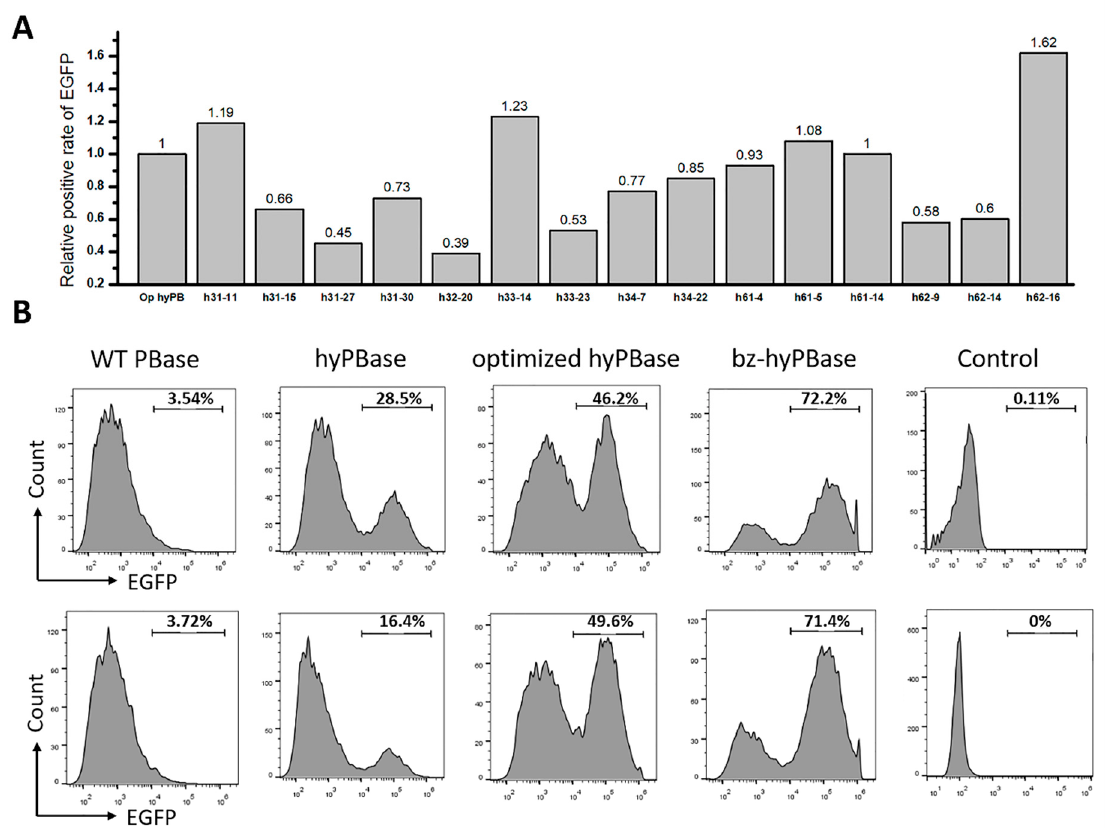
Figure 4. Hyperactive piggyBac transposase mutants in mammalian Cells. ( A ) Relative activities of 15 hyperactive mutants in Chinese hamster ovarian carcinoma (CHO) cells. The transposon plasmid pSAD-EGFP containing EGFP in transposon and the transposase plasmid pLoxP-optimized hyPBase or pLoxP -mutant containing transposase were coelectrotransformed into CHO cells. After 7 days of culture, the cells that expressed green fluorescent protein were counted by flow cytometry. ( B ) Relative activities of WT PBase, hyPBase, optimized hyPBase, and bz-hyPBase. The upper and the lower row are two repeated results. The control cells containing plasmid pSAD-EGFP only showed almost no green fluorescent protein expression. The X-axis represented the intensity of EGFP, and the Y-axis represented the number of cells. The values represented the percent of EGFP cells in each sample.